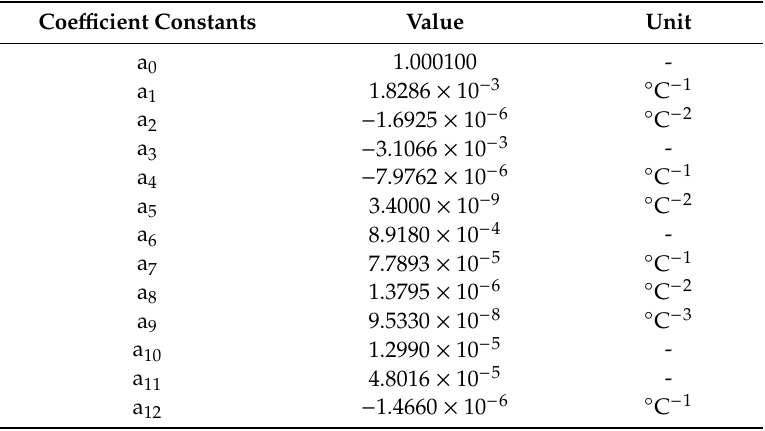
Table 1. Coe ffi cients for the computation of c / c 0